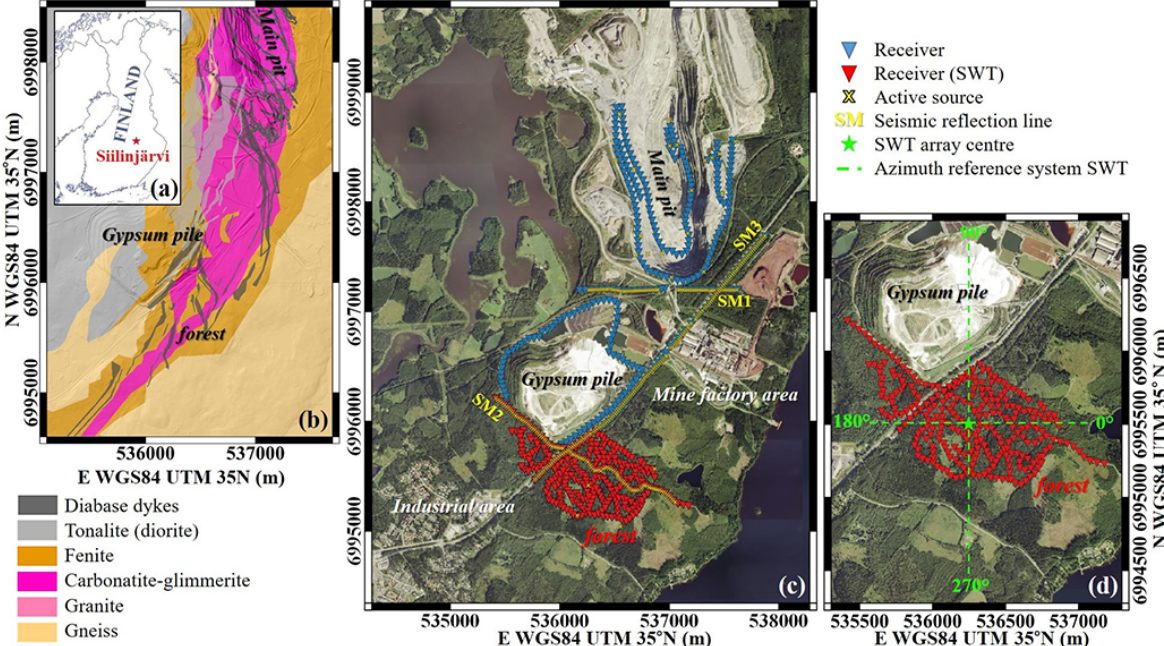
Figure 1. Siilinjärvi mine: (a) geographical location; (b) geological map (Yara); (c) active and passive seismic surveys acquired in 2018; (d) zoom on the passive seismic array in the southern area, used for passive surface-wave tomography (SWT). The reference system for azimuth analysis is highlighted in green. Orthophotos available from QGIS plugin QuickMapServices (Kapsi – ortoilmakuva